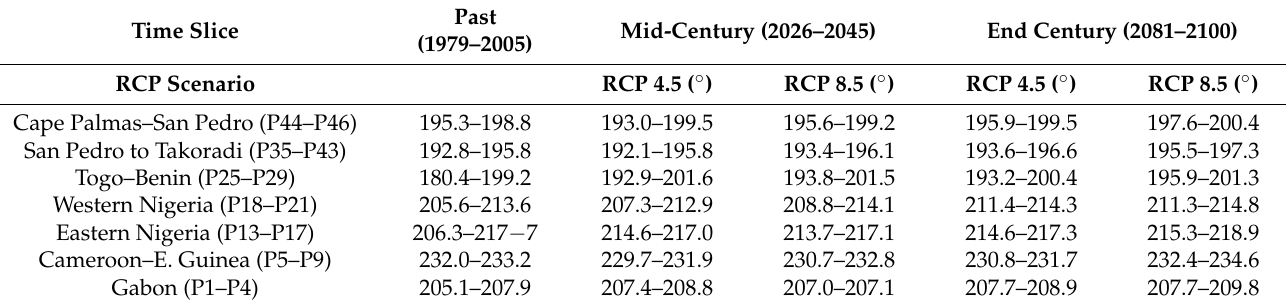
Table 11. Average extreme Dm (winter–summer) for uniform locations in the